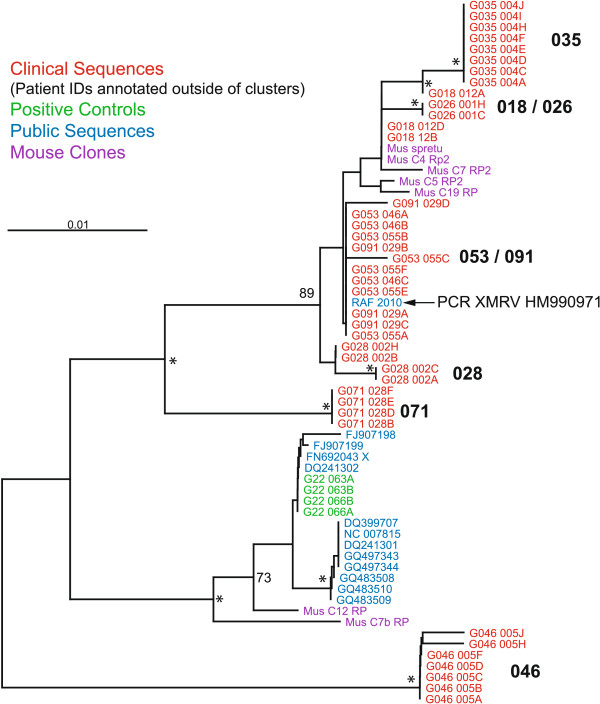
Phylogenetic tree of murine retroviral DNA sequences from CFS and healthy subjects. Results are displayed for one CFS Positive Control Subject (G018), five CFS Subjects (G026, G028, G035, G071 and G091) and two Healthy Subjects (G046 & G053). For these subjects, the first four letters/digits are subject anonymous identifier numbers while the last four letters/digits identifies replicates. Public MLV (blue text) and top mouse clone hits, which are also retroviral homologs (purple text), are included in the tree reconstruction. The position of the previously reported, PCR XMRV contaminant sequence (HM990971) is indicated [29]. The tree was reconstructed by neighbor-joining (NJ) method using DNA distance matrices of core conserved nucleotides (see Methods). Asterisks (“*”) indicate those nodes supported 70% or greater in 1000 bootstrap replicate NJ trees and 0.95 Bayesian posterior probability while nodes with numbers had high NJ bootstrap values only. Scale bar represents 0.1 expected nucleotide substitutions per site.